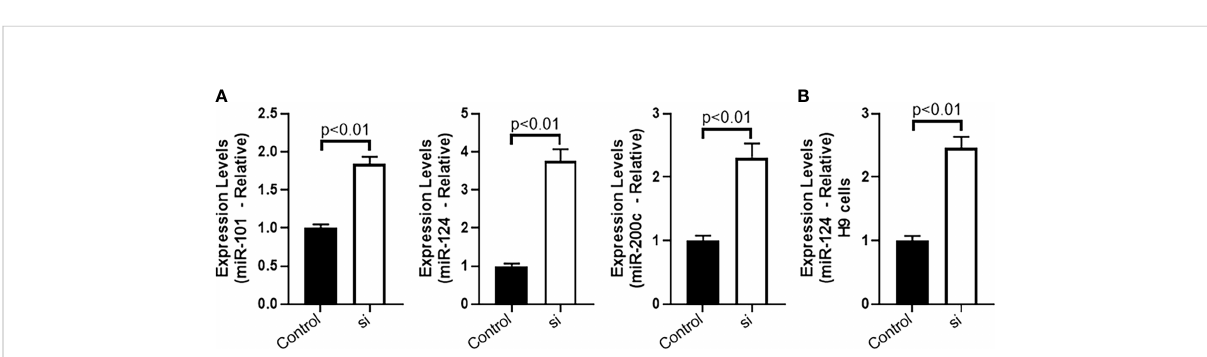
FIGURE 5 Sponging of miRNAs by MALAT1 in CTCL cells. (A) miR-101, miR-124 and miR-200c were quantitated in HH cells followed by evaluation of miR- 124 in H9 cells (B)